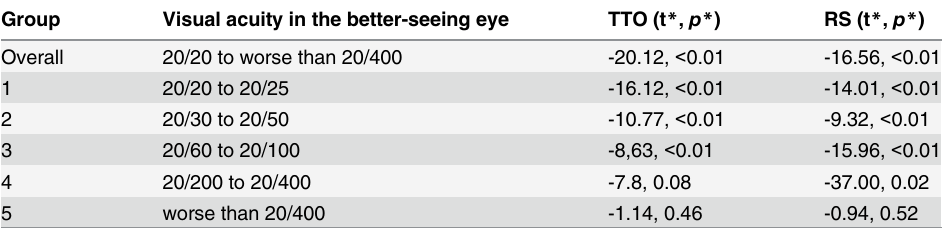
TTO, time trade-off; RS, rating